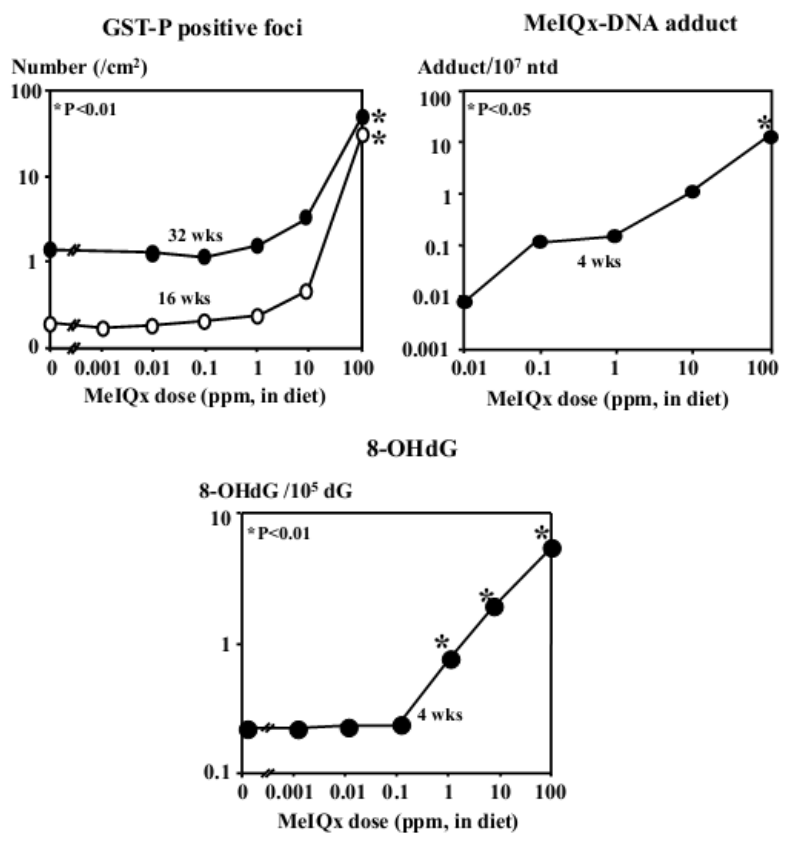
Figure 4. Hepatocarcinogenicity of MeIQx at low doses in rats.